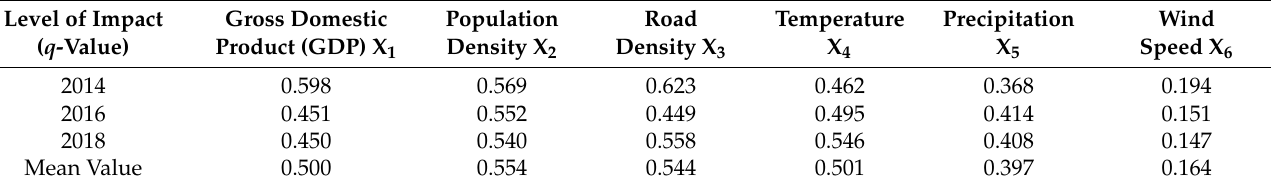
Table 4. Detection results of single driving